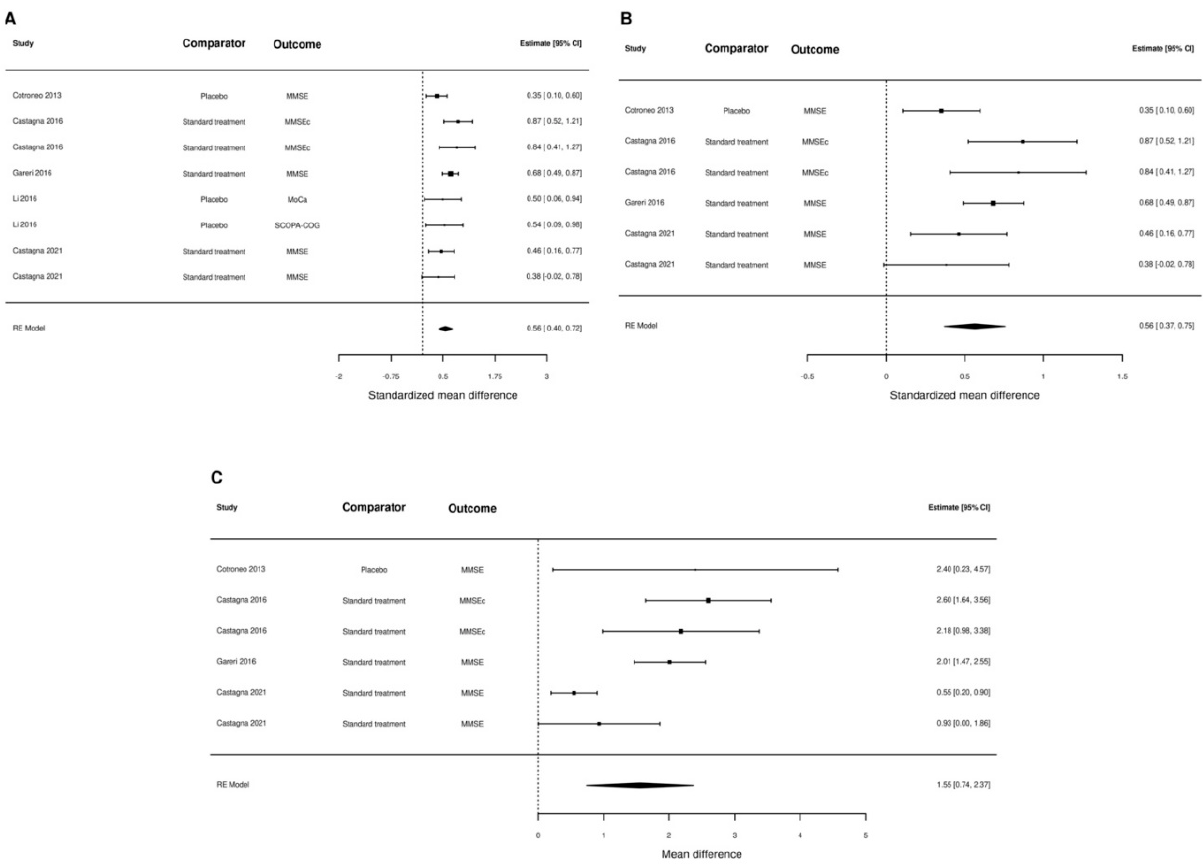
Figure 2. Forest plot summarizing all studies (panel ( A )), only observational studies (panel ( B )), and only studies using MMSE as outcome measure (panel ( C )). SD were calculated assuming a small correlation coefficient (r = 0.6).